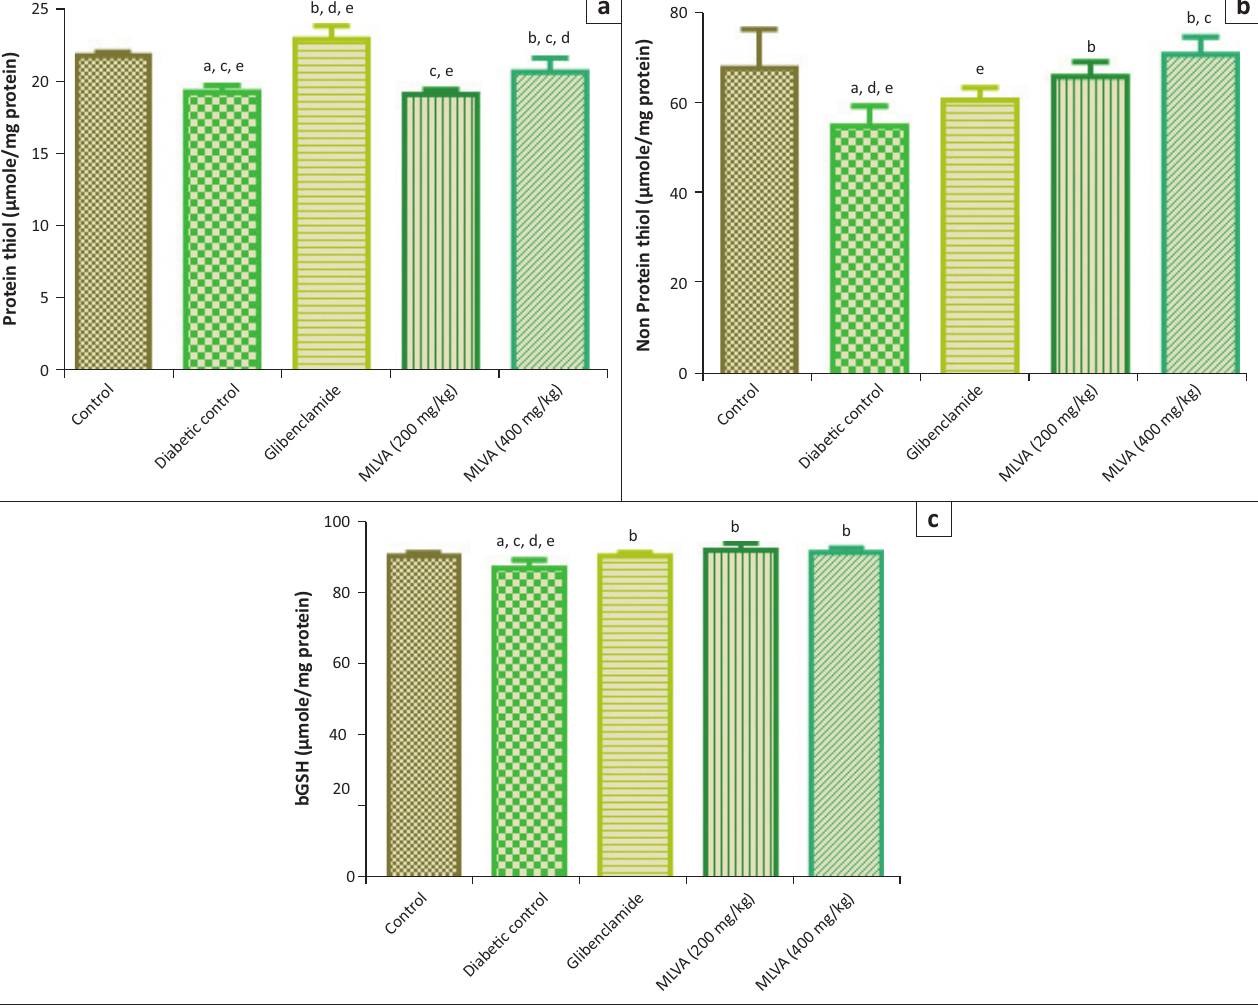
FIGURE 3: Effect of methanol leaf extract of Vernonia amygdalina (MLVA) on protein thiol (a), non-protein thiol (b) and reduced glutathione (GSH) (c) concentration in intestinal tissue of alloxan-induced diabetic rats. Values are mean ± SD, n = 5, a p < 0.05 compared with control, b p < 0.05 compared with diabetic control, c p < 0.05 compared with glibenclamide, d p < 0.05 compared with MLVA, 200 mg/kg and e p < 0.05 compared with MLVA, 400 mg/kg.